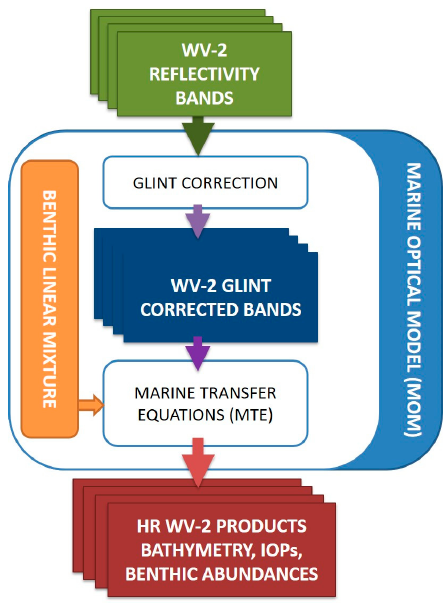
Figure 5. Proposed diagram of the radiative transfer model using linear mixture of benthic elements.